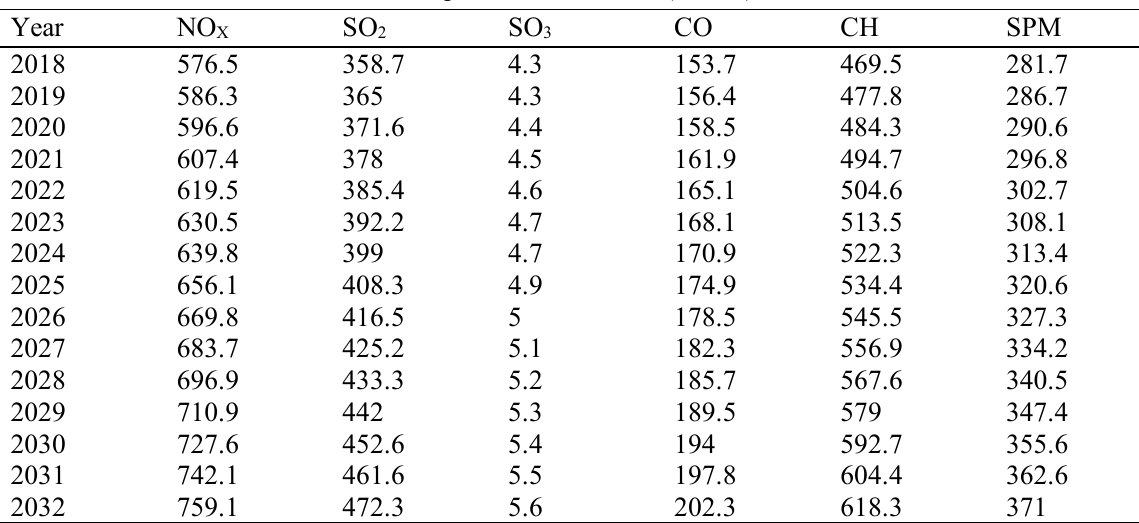
Table 7. Projected the air pollutant emissions from SWCTT in Tehran